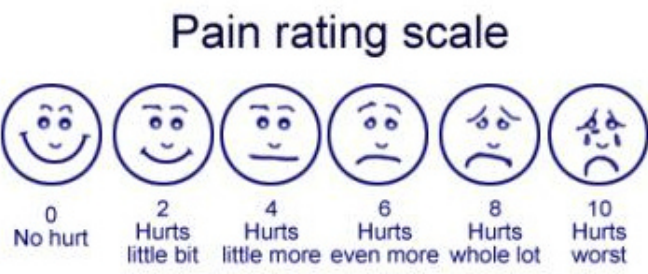
Figure 2. Example of a visual analog scale to measure pain. Participants are requested to rate their perceived pain choosing one of the six different options. No copyrighted